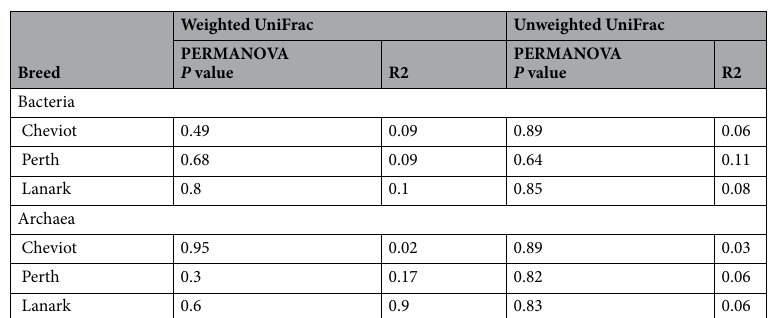
Table 7. Beta diversity analysis. Effect of fraction on bacterial and archaeal community composition for Cheviot, Lanark and Perth breeds. Community dissimilarities calculated using weighted and unweighted UniFrac distances and compared among breeds using PERMANOVA. P values and R2 values reported. Cheviot (solid n = 7, liquid n = 7, epithelial n = 7), Lanark (solid n = 5, liquid n = 5, epithelial n = 5), Perth (solid n = 5, liquid n = 5, epithelial n =